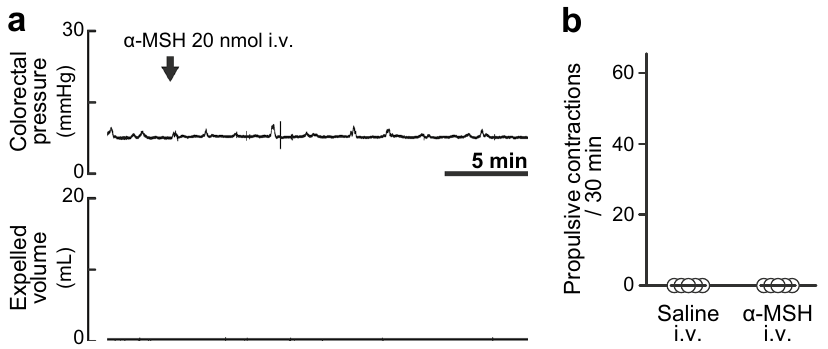
Figure 2. Effects of intravenous injection of α-MSH. ( a ) Typical traces of colorectal pressure (upper) and expelled volume (lower) with intravenous injection (i.v.) of α-MSH (20 nmol). α-MSH i.v. had no effect on colorectal motility. ( b ) Summarised graph of number of propulsive contractions during a period of 30 min after saline i.v. or α-MSH i.v. (20 nmol). There was no significant difference between the saline group and α-MSH group. Each open circle ( ○ ) indicates a result from an individual rat, and the black bar shows the median. Five rats were used in each group.